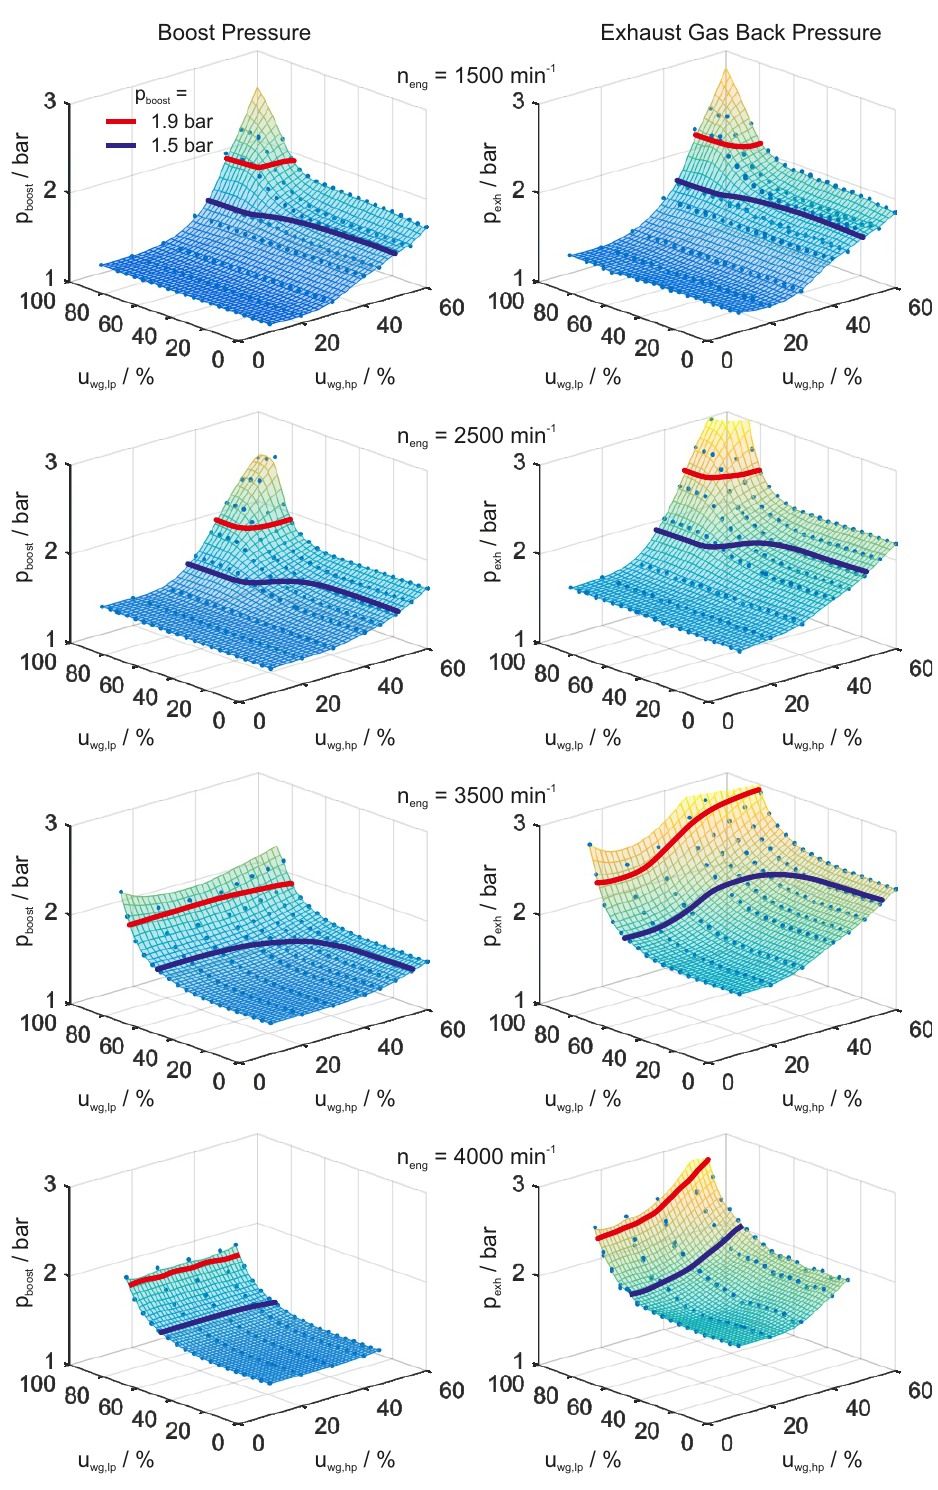
Figure 3. Maps with boost pressure and exhaust gas back pressure for different engine speeds with iso-curves on p boost